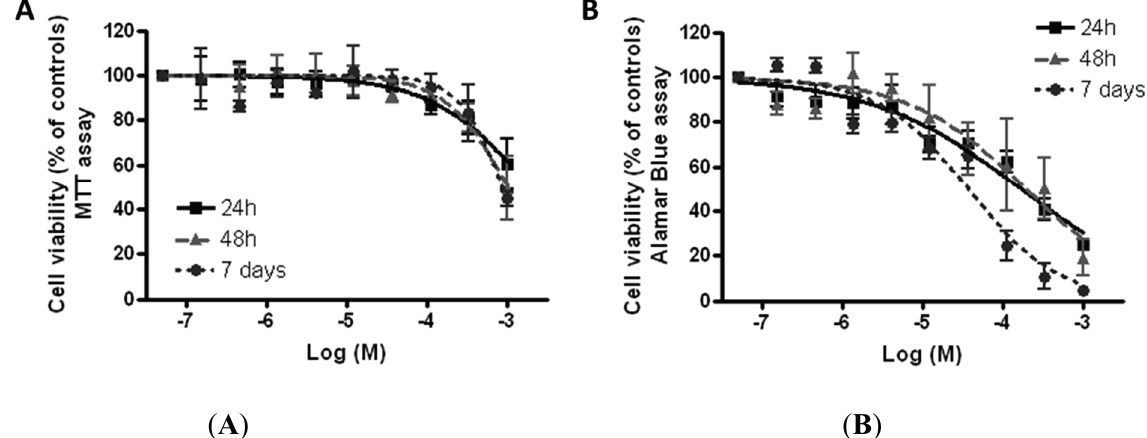
Figure 4. Cytotoxicity of TiO 2 NPs. Cell viability was measured by MTT assay ( A ) and